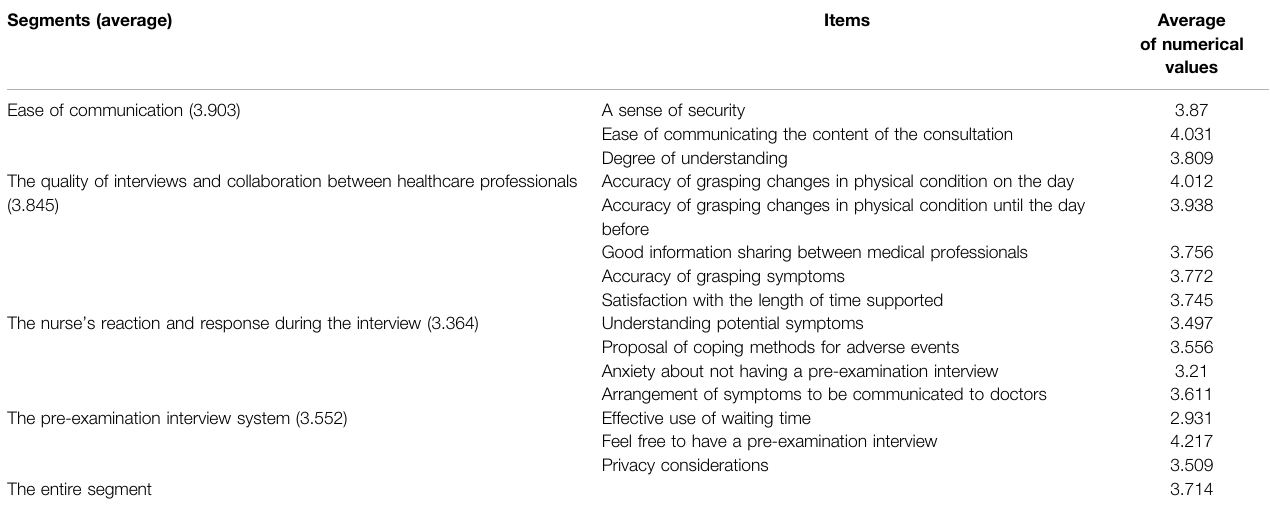
of numerical values